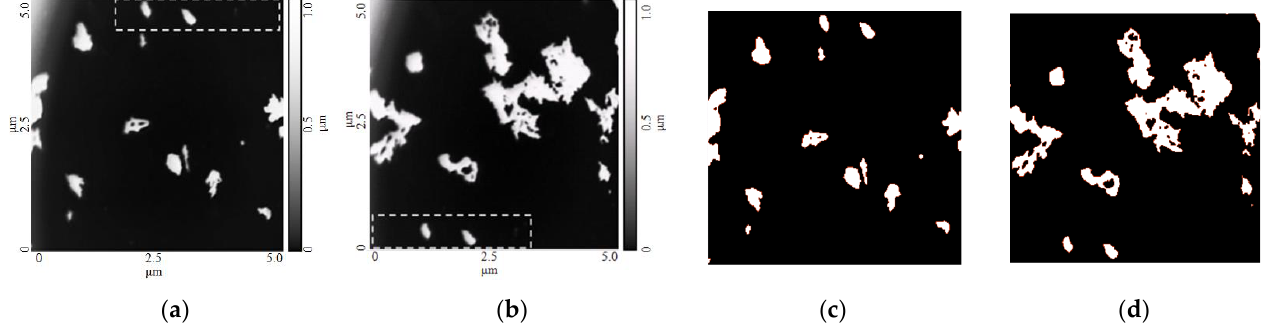
Figure 4. Overlapping copper microparticles images (256 × 256 pixels): ( a , b ) source images with marked overlap area; ( c , d ) the results of segmentation by GrainAnalysis.